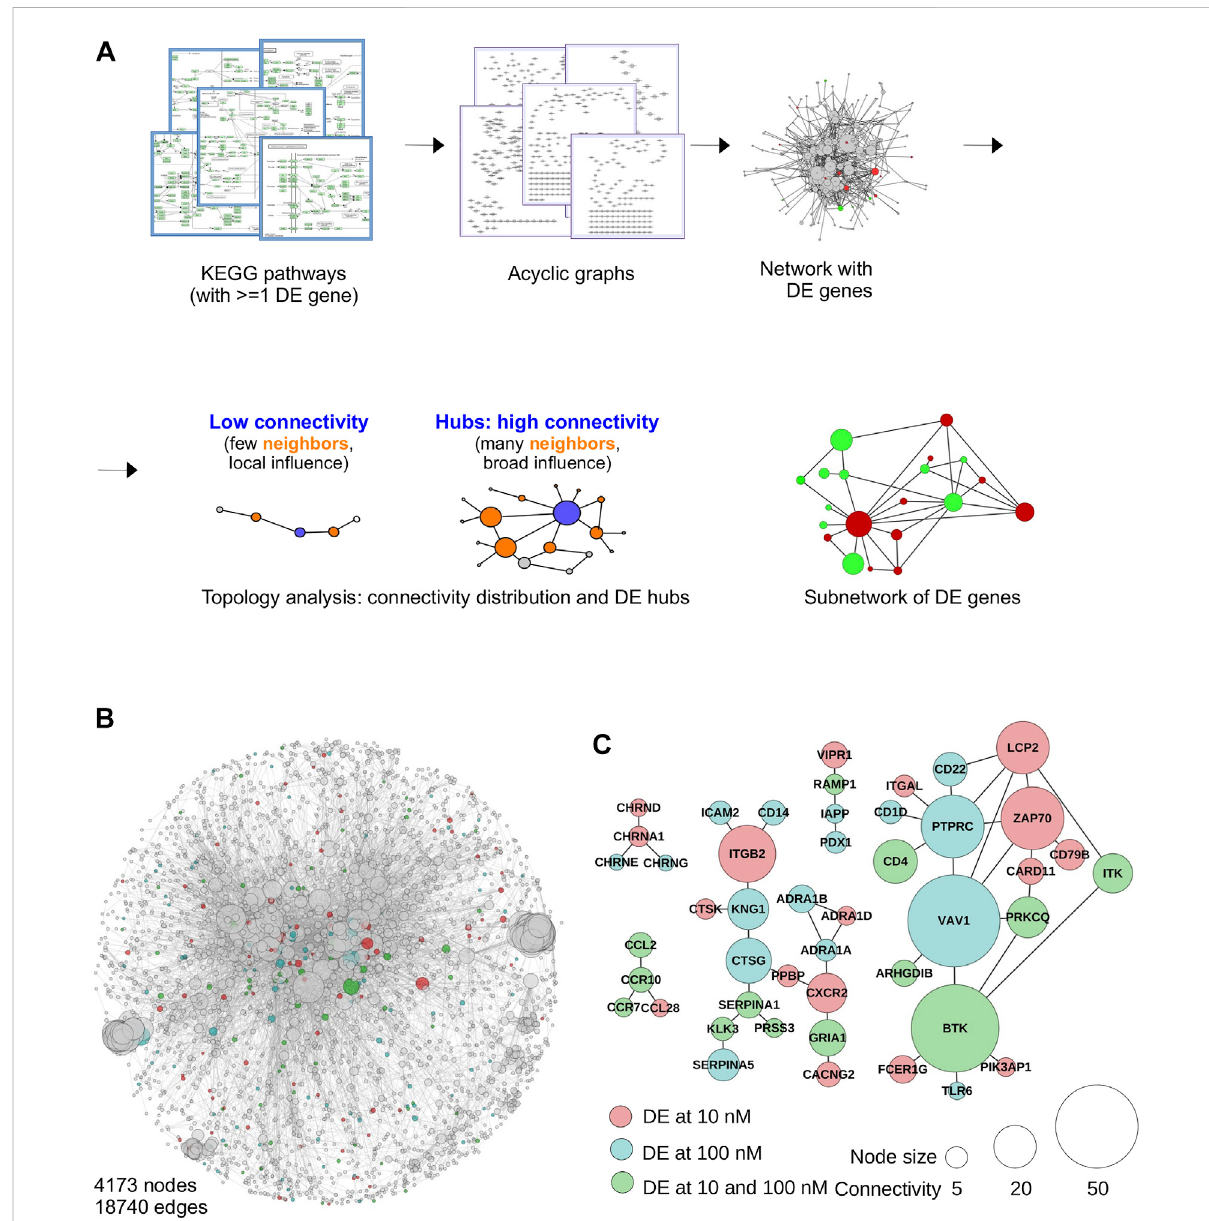
FIGURE 2 Integrative analysis of TBBPA-induced perturbations in biological networks. (A) Principle of network reconstruction, by combining all KEGG pathways containing at least one DE gene, and merging together individual graphs (pathways). The resulting network is then annotated with DE genes, highlighted in color. The network is then used to interrogate individual node ’ s connectivity and detect the in fl uence of DE genes in the network (local vs. broad), and identify subnetworks representing focus points of action. (B) The reconstructed network (4,173 nodes, 18,740 edges) has the typical structure of scale free networks, with a large number of low connectivity nodes and a limited number of hubs. Connectivity isdisplayedasnodesize.DEgenesarecolor-coded. (C) Subnetworksobtained after9daysTBBPAtreatment,showingalltheDEgenes functionally interacting with each other. Most contain only a few nodes, except much largest